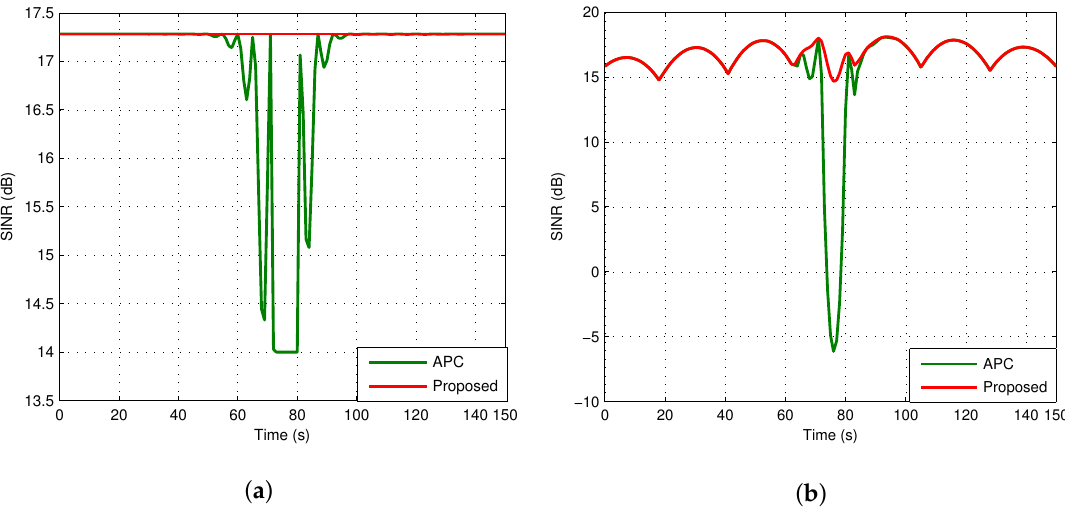
Figure 8. Comparison of SINR between the APC and the proposed algorithm. ( a ) GEO user; ( b ) LEO user.